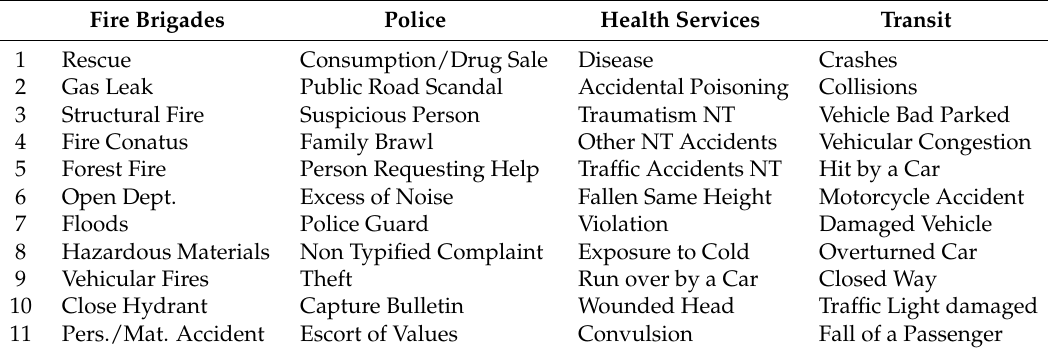
Table 6. Categories used in the experimental results, ordered by